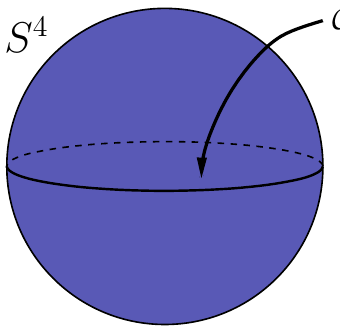
Figure 3. The contour C that defines the Wilson line is a great circle on S 4